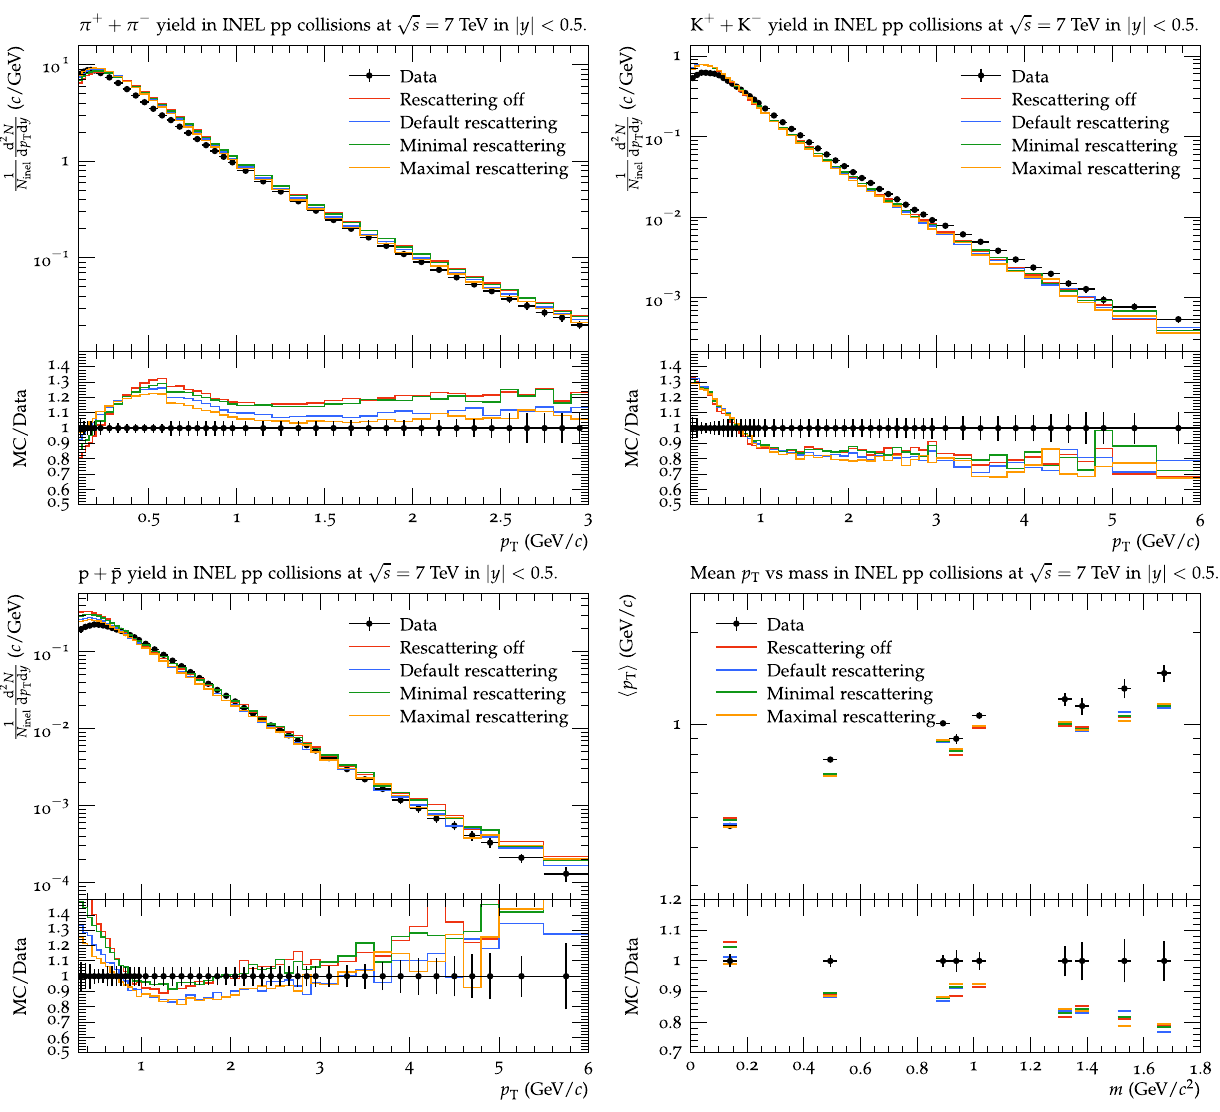
Fig. 20 p ⊥ spectra for π ± , K ± and p / p and average p ⊥ for various particles, for different parameter